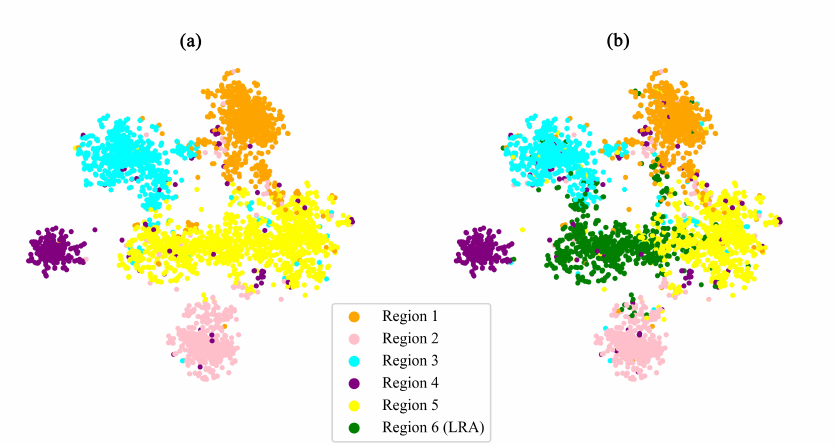
Figure 9. Two-dimensional visualization of the regions using the t-SNE algorithm. Subfigure ( a ) is colored according to our results; subfigure ( b ) is colored according to results of